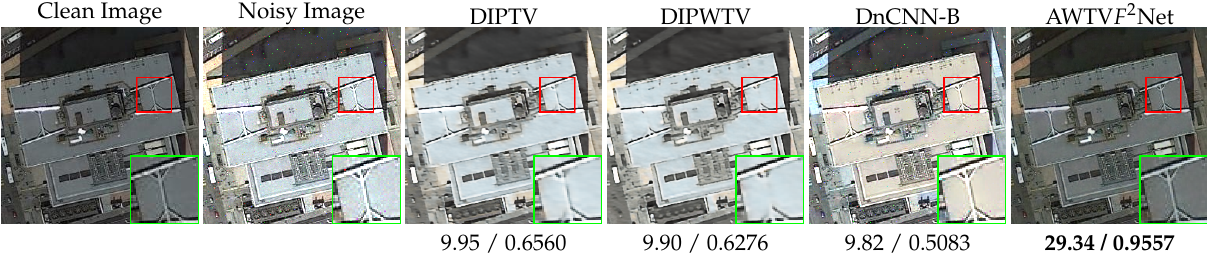
Figure 18. Enlarged details of the ‘Commercial area’ image with the third case of mixture